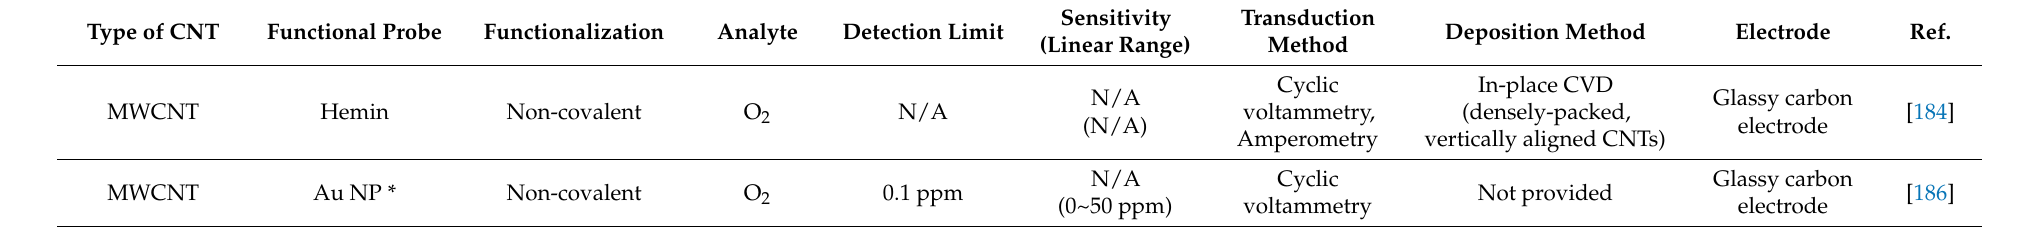
Table 13. CNT-based dissolved oxygen sensors in water.